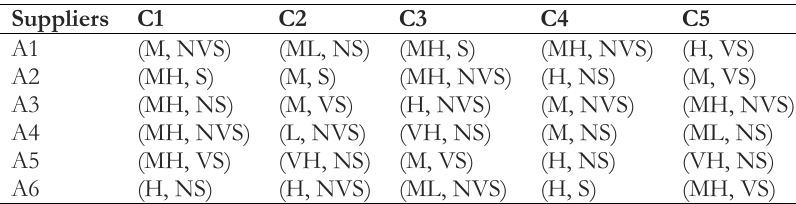
Table 4. Linguistic preferences of Expert 2 [16].